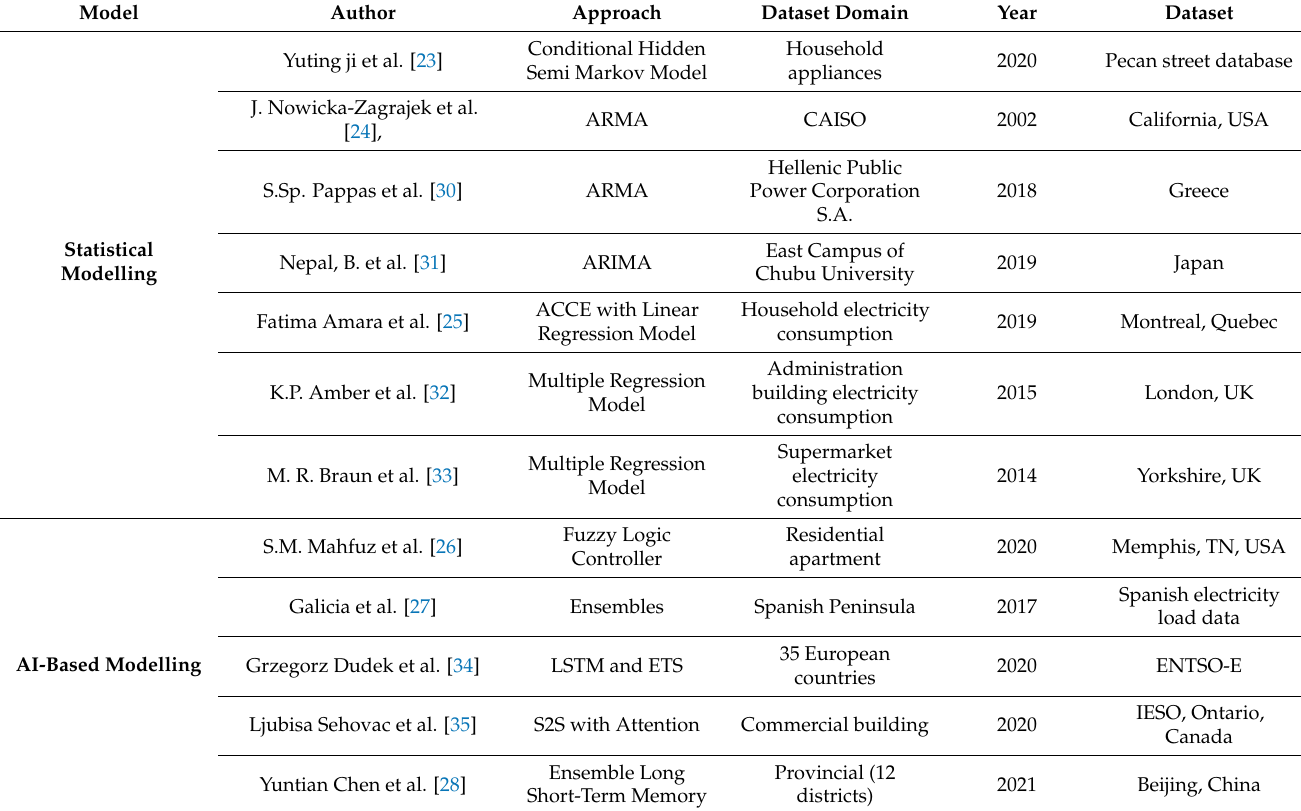
Table 1. Review of the recent publications in energy load